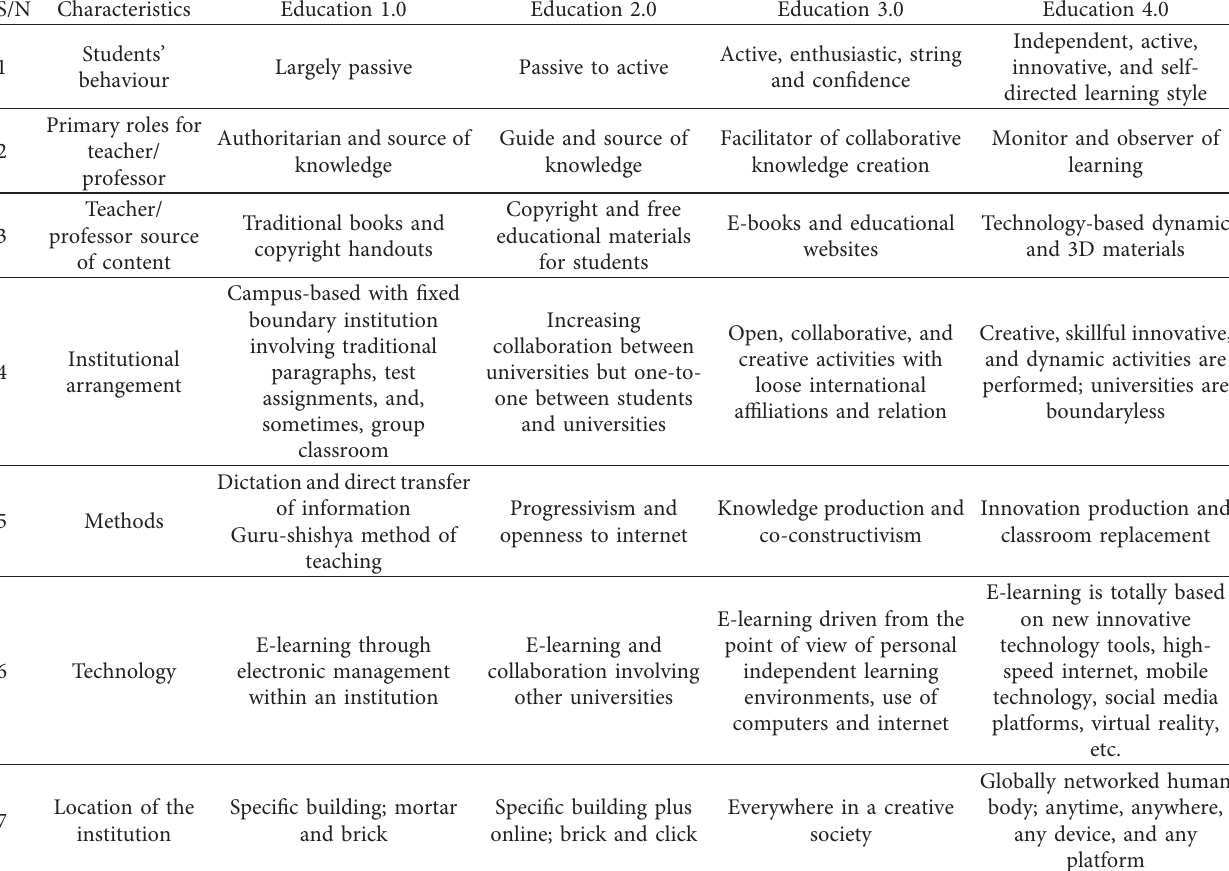
Table 3: Characteristics of education generations.